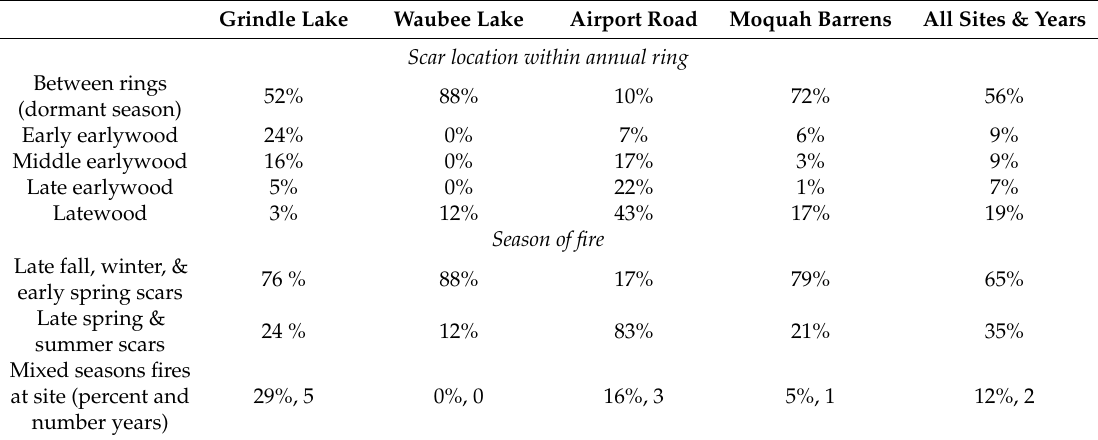
Table 3. Fire scar positions within annual rings and their related fire seasonality. Season of fires are the percent of scars in each scar